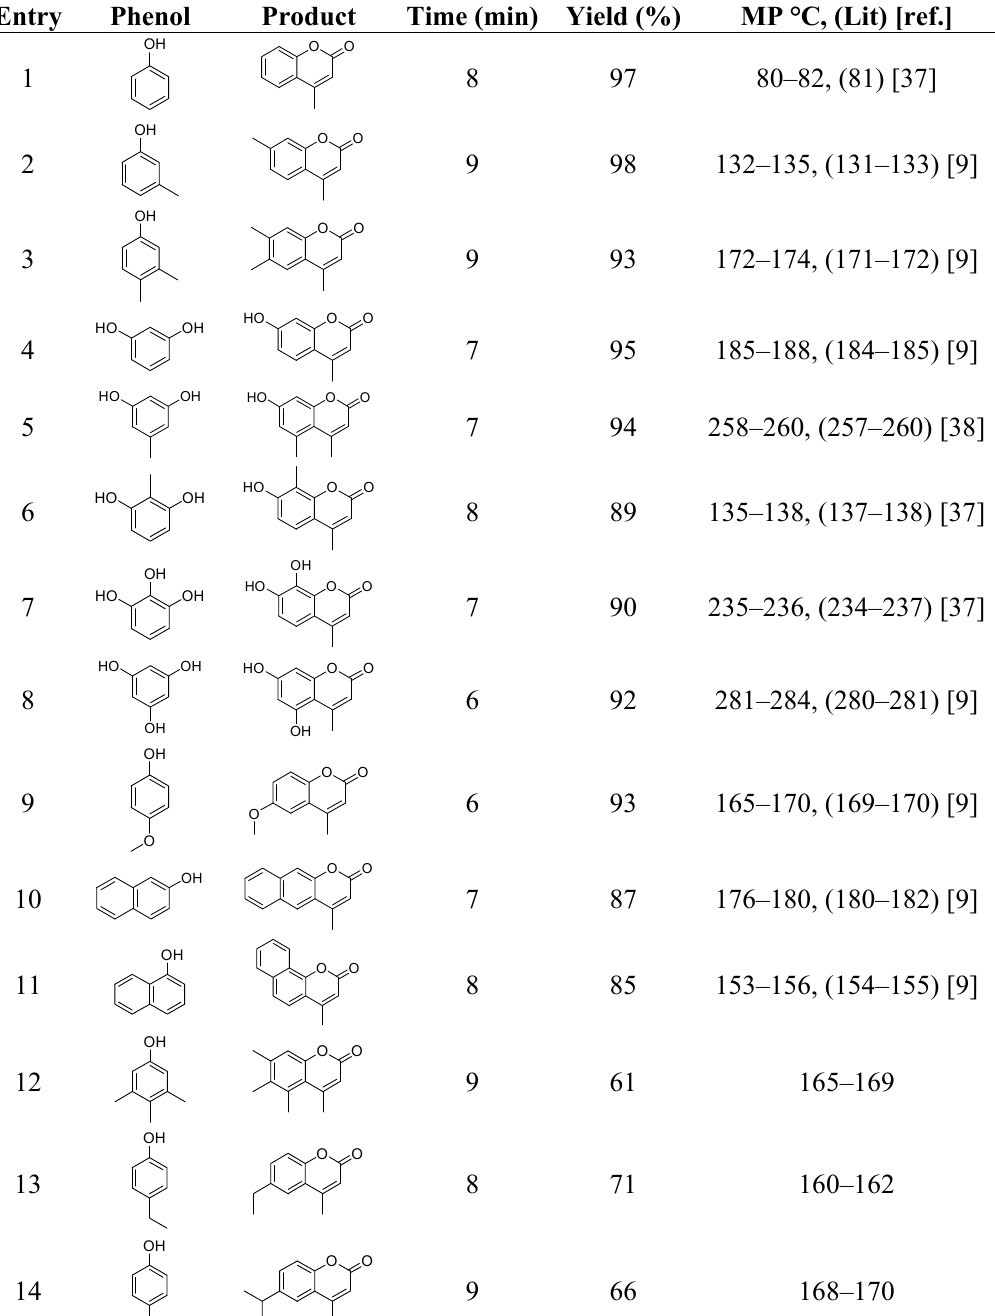
Table 1. FeF catalyzed synthesis of coumarin derivatives a 3